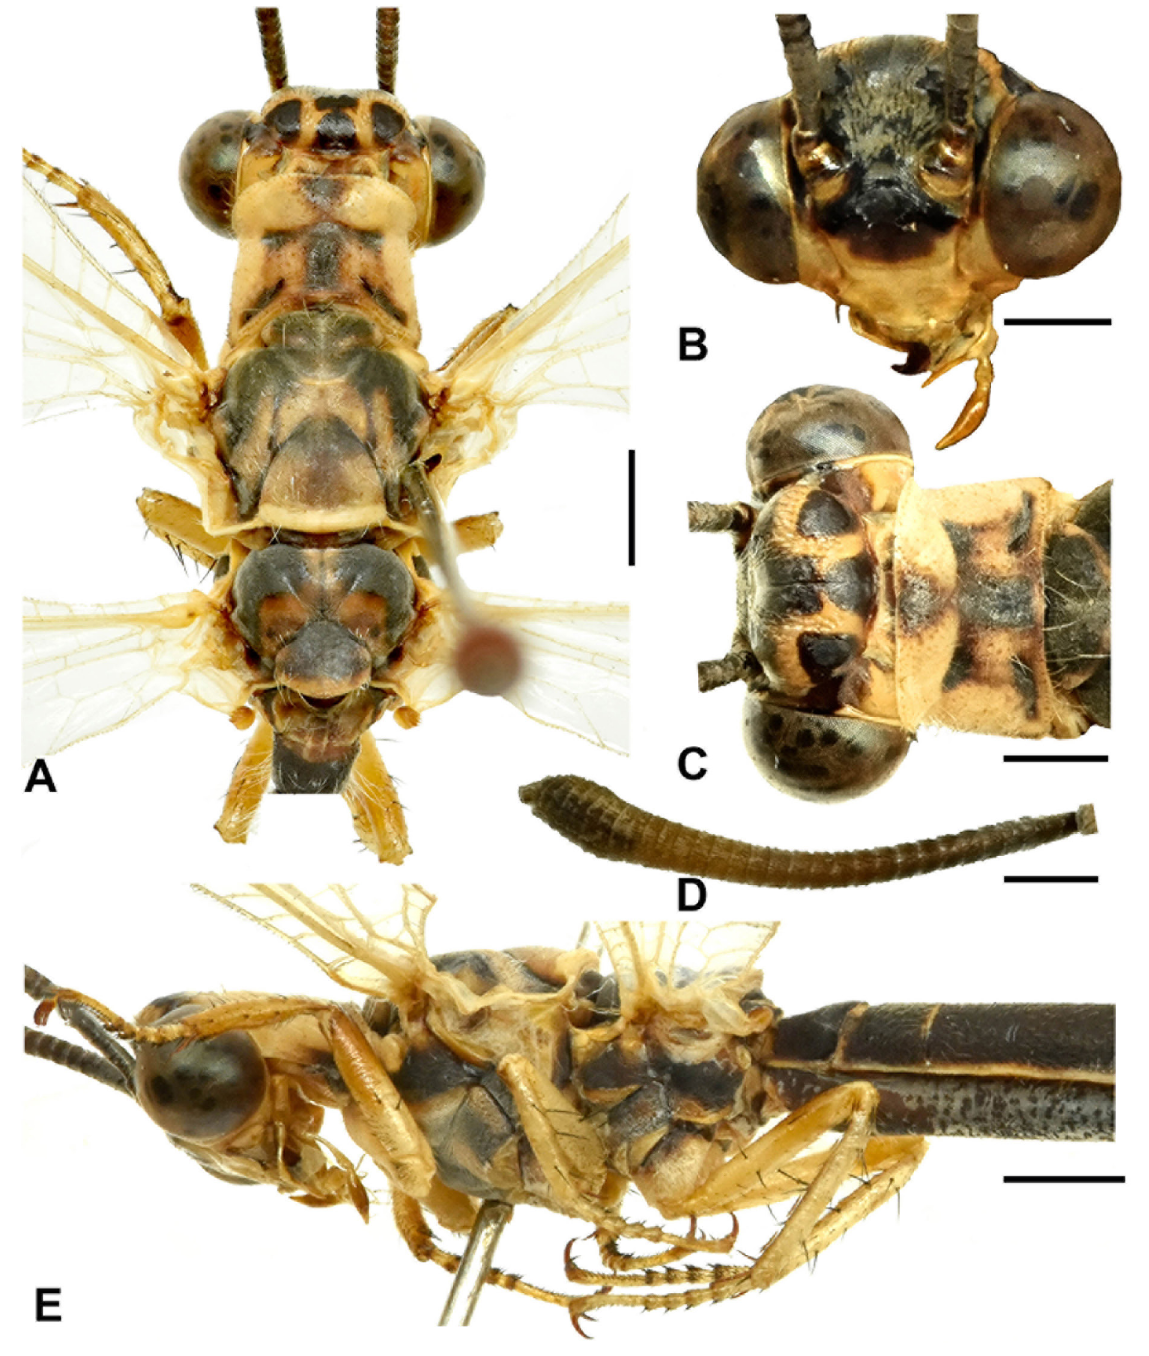
Fig. 14. Myrmeleon hyalinus hyalinus Olivier, 1811 (CAUPK000024). A . Dorsal habitus of head and thorax. B . Head, frontal view. C . Head and pronotum, dorsal view. D . Antenna. E . Lateral view. Scale bars: A = 2.0 mm; B–D = 1.0 mm; E = 3.0